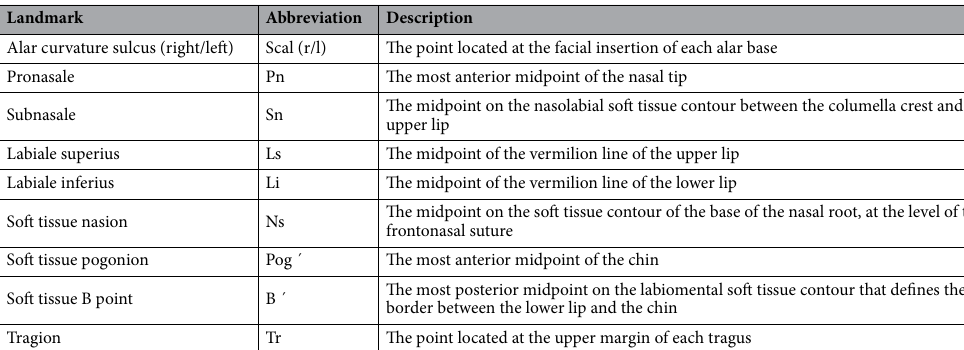
Table 2. Landmarks for the facial